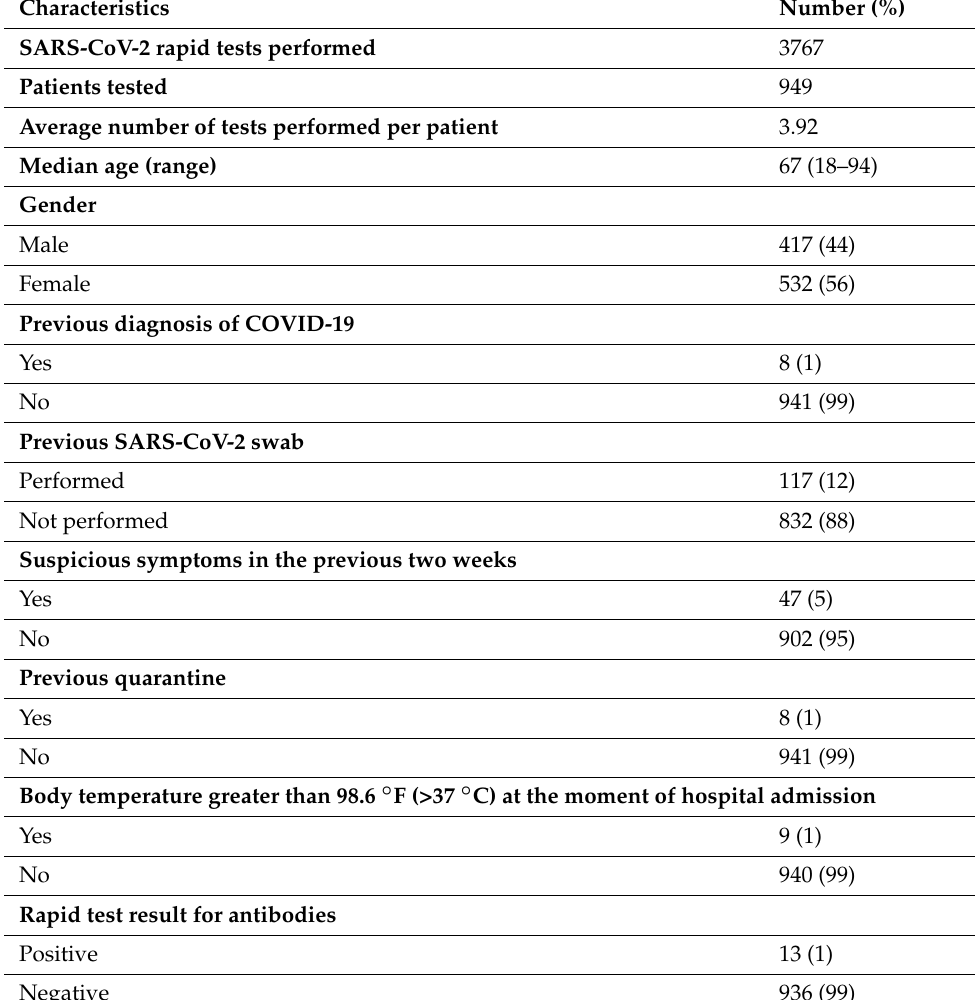
Table 1. Characteristics of tested patients.